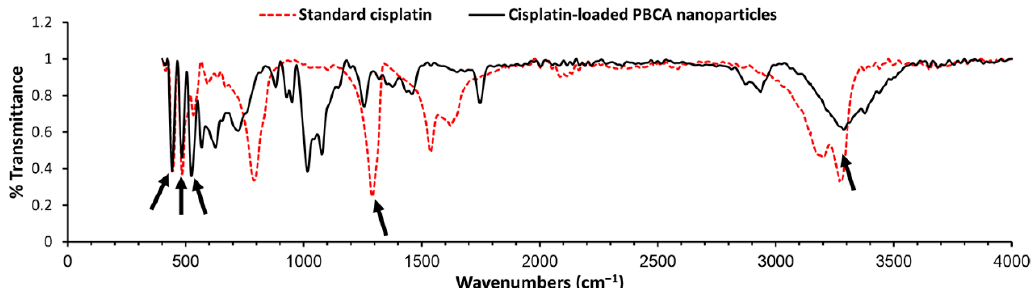
Figure 3. Fourier-transform infrared (FTIR) spectrum of the standard cisplatin and cisplatin-loaded PBCA nanoparticles. Arrows show the position of chemical bonds of cisplatin [26] .